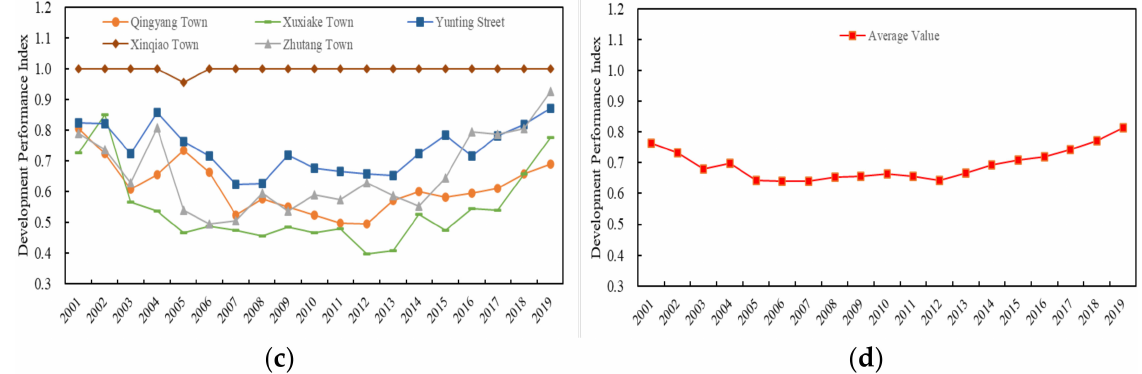
Figure 3. Trends in the development performance of small towns in Jiangyin from 2001 to